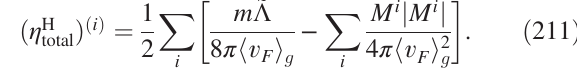
FIG. 4. Contour plot of the density γ symmetric Chern insulator. The plot is shown with the hopping parameters t ¼ 20 and t 0 ¼ 21 , m ¼ 0 . 25 , a ¼ 1 , and r ¼ 1